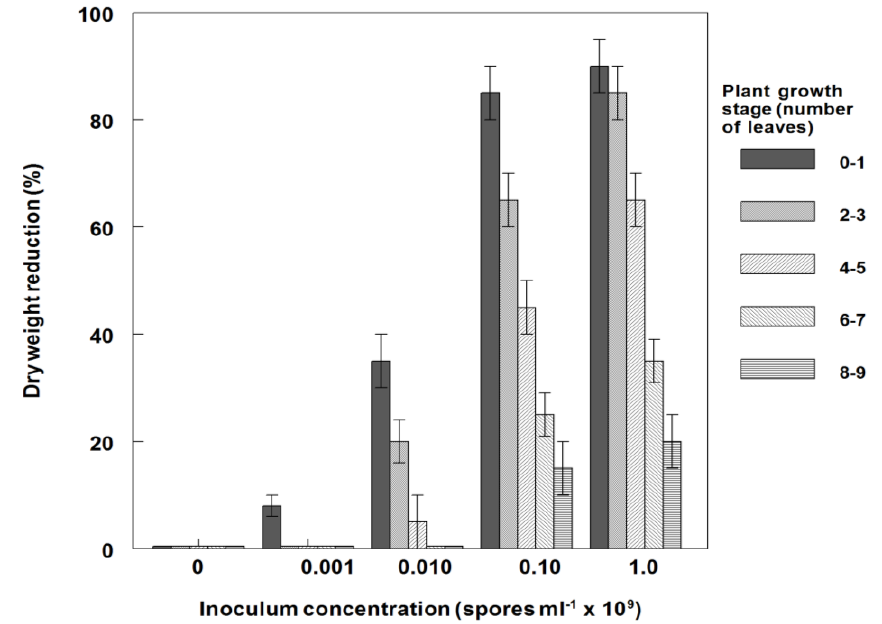
Figure 7. Effect of plant growth stage on dry weight reduction of spreading dayflower inoculated with P. commelinicola at various inoculum concentrations under greenhouse conditions. Error bars represent Fisher’s LSD ( p =